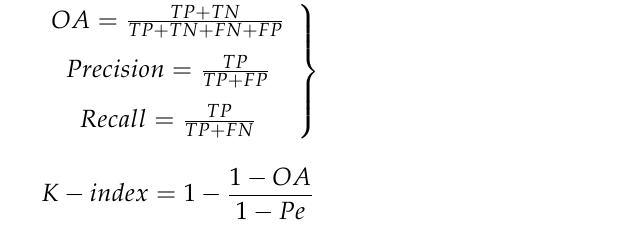
(B5:705 nm), SWIR_1 (B11:1610 nm), SWIR_2 (B12:2190 nm) and the VH polarization.